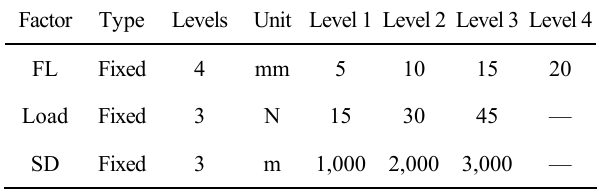
Table 5 Factors and their corresponding levels.